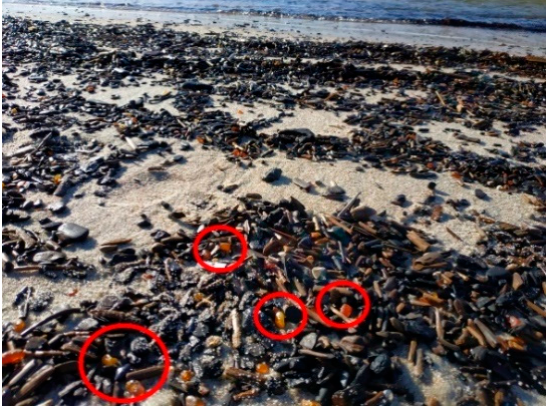
Figure 2. Example of marine debris wash-out with amber.